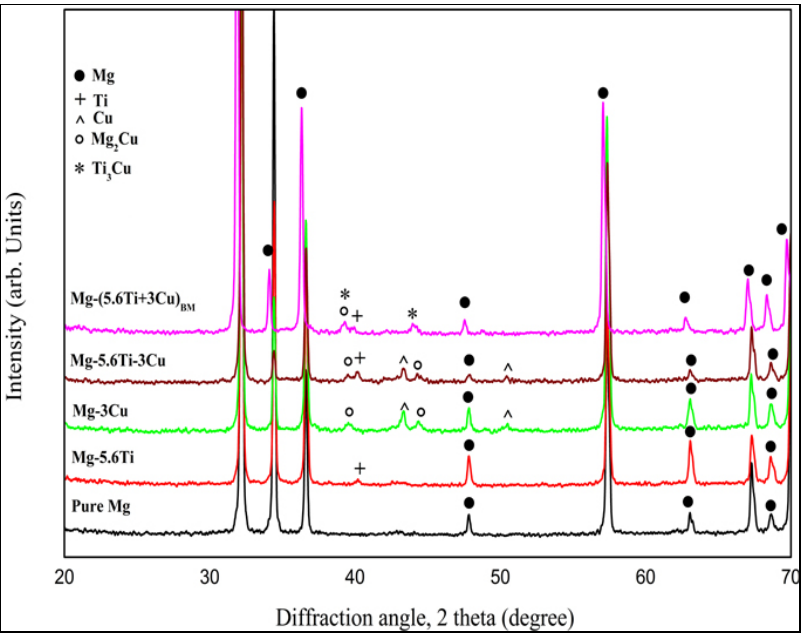
Figure 1. X-ray diffractograms of developed Mg based